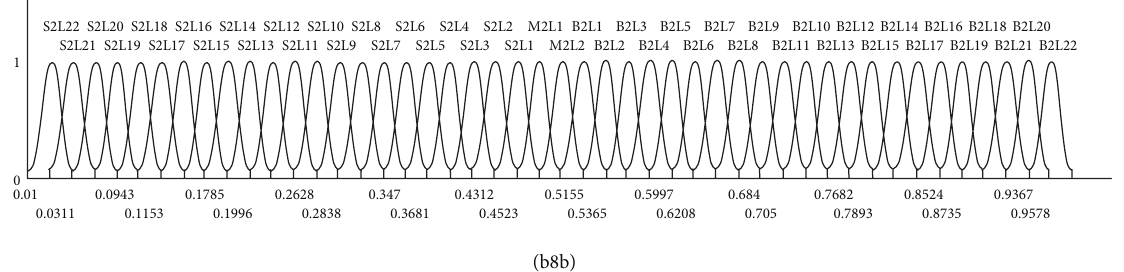
Figure 7: (a) Fuzzy controller. (b1) Membership functions for relative natural frequency for first mode of vibration. (b2) Membership functions for relative natural frequency for second mode of vibration. (b3) Membership functions for relative natural frequency for third mode of vibration. (b4) Membership functions for relative mode shape difference for first mode of vibration. (b5) Membership functions for relative mode shape difference for second mode of vibration. (b6) Membership functions for relative mode shape difference for third mode of vibration. (b7a) Membership functions for relative crack depth 1. (b7b) Membership functions for relative crack depth 2. (b8a) Membership functions for relative crack location 1. (b8b) Membership functions for relative crack location